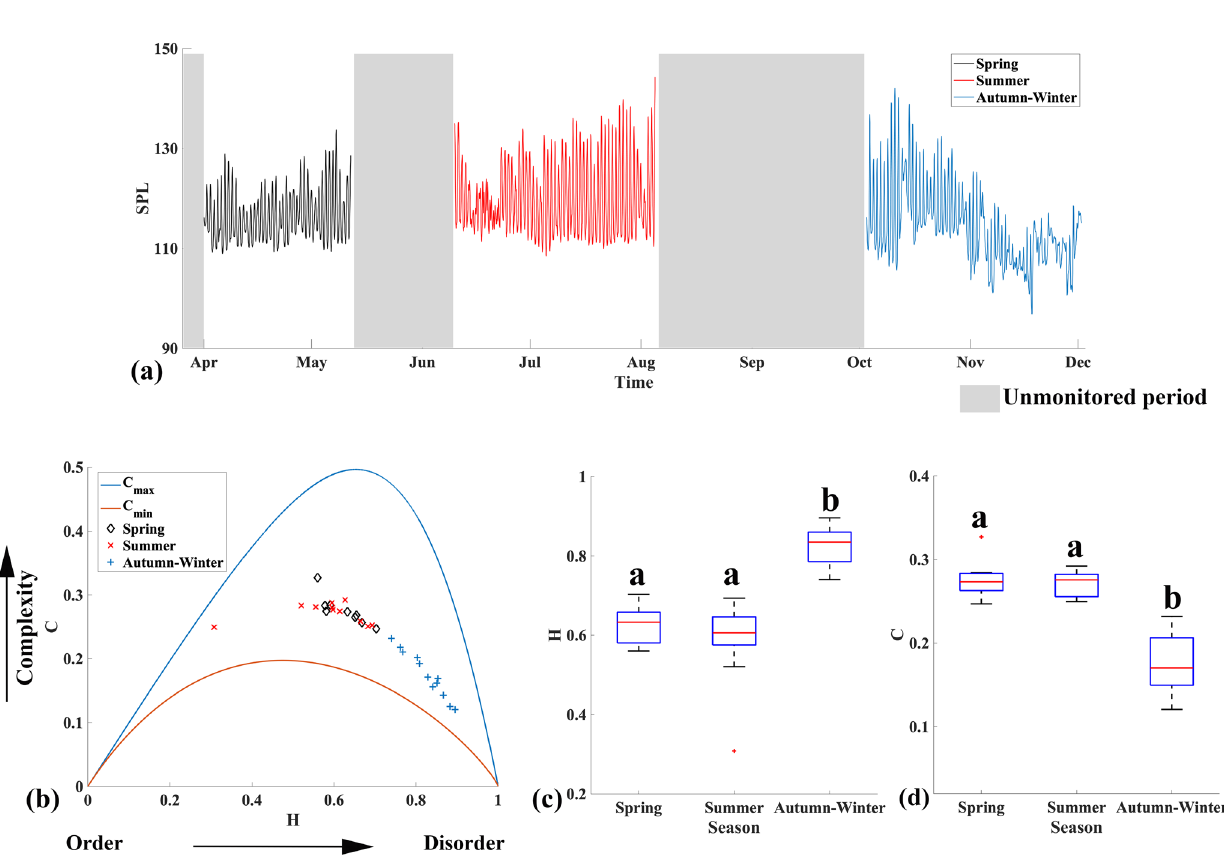
Fig. 3 Seasonal variation of the complexity (C) and regularity (H) of the sound pressure level. a Seasonal sound pressure variation (SPL in units of dB re 1 μ Pa) at the Changhua monitoring site during the year 2017. b C and H during different seasons are plotted on the C-H plane. c , d Comparison of H and C during spring ( n = 9), summer ( n = 12), and autumn-winter ( n = 12). Each box with a superscript letter represents the results from a post hoc multiple comparison test. In each box, the central red mark depicts the median, and the top and bottom edges of the box represent the 25th and 75th percentiles. The maximum and minimum values are marked in black at the extreme ends. Whiskers and Lines (black) delineate 95% con fi dence intervals. The symbol ‘ + ‘ represents outliers. Different superscript letters indicate signi fi cant differences ( p < 0.05), with the letter ‘ a ’ at the top and subsequent statistical differences are represented at a lower